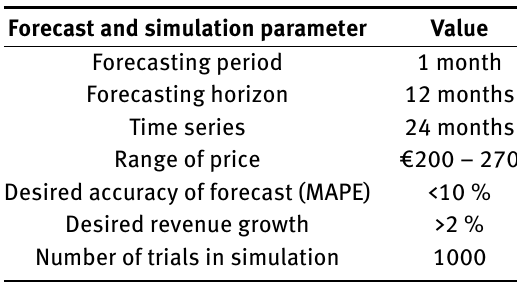
Table 2: Input parameters for forecasting.